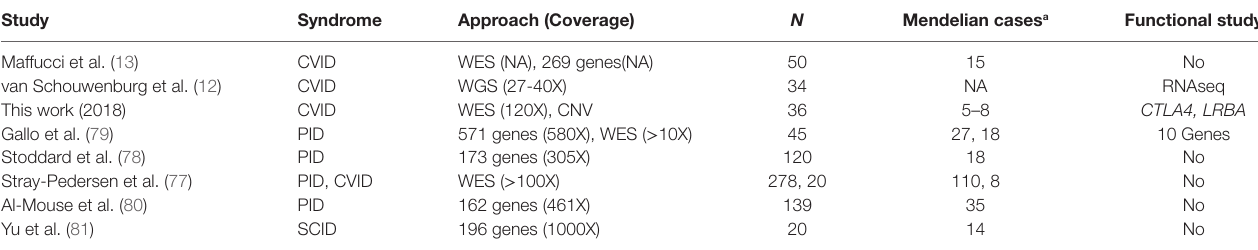
TaBle 10 | NGS studies on common variable immunodeficiency (CVID) and other primary immunodeficiency (PID).